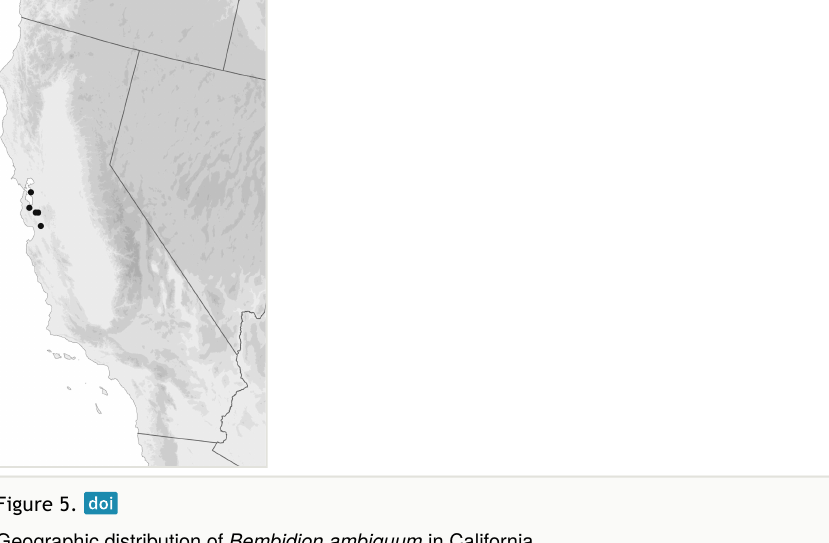
Geographic distribution of Bembidion ambiguum in